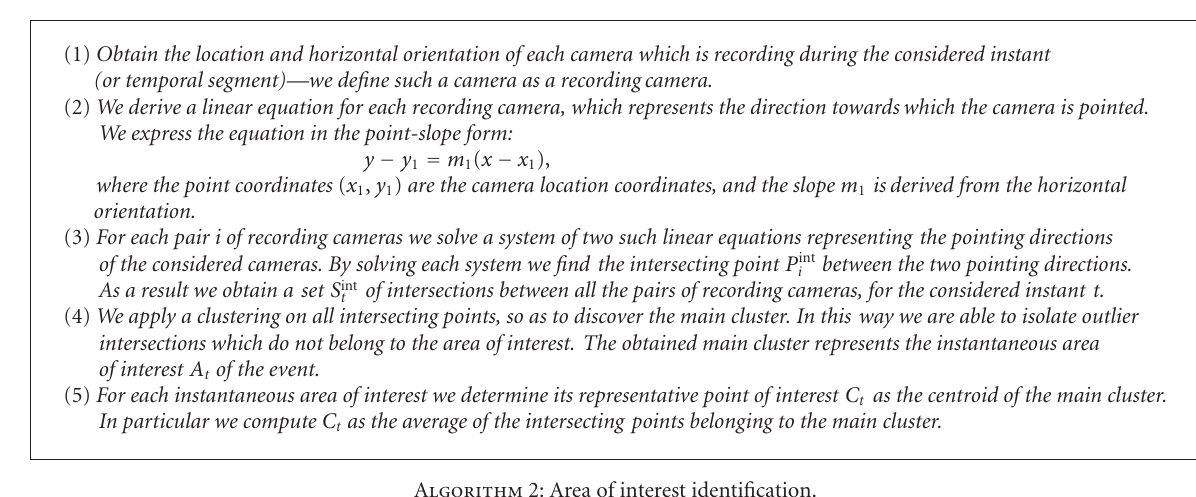
Algorithm 2: Area of interest identification.